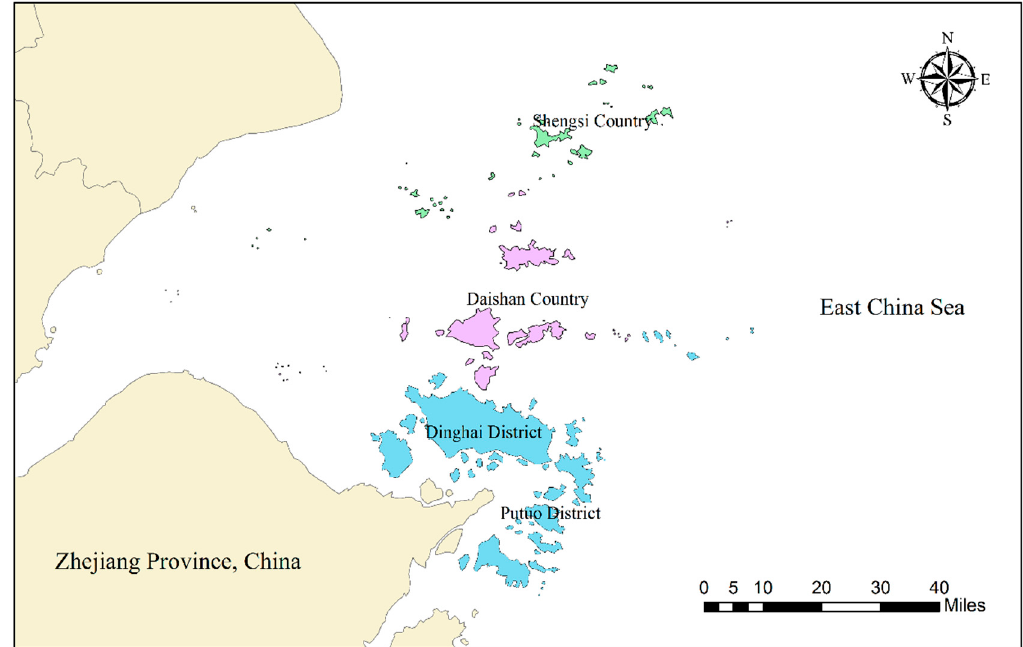
Figure 2. Locations of prefectures considered in this study.